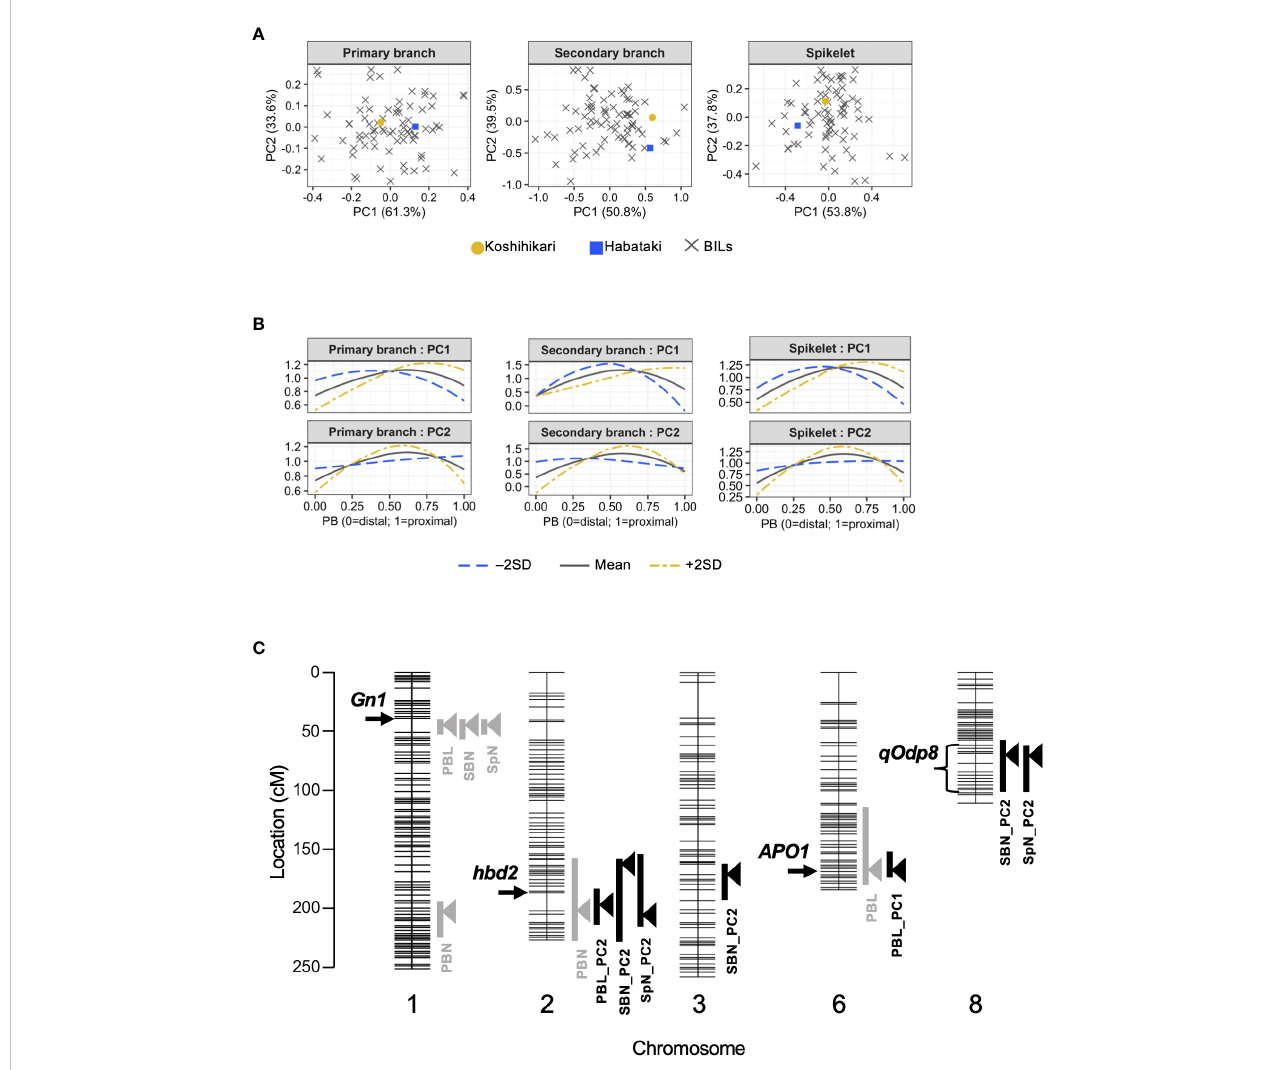
FIGURE 2 Quantitative trait locus (QTL) analysis of organ distribution patterns. (A) Organ distribution patterns in backcrossed inbred lines (BILs) derived from Koshihikari and Habataki. (B) Effect of each principal component (PC). Estimated organ distribution patterns were recalculated for mean ± 2 standard deviations (SD) of the PC. (C) Chromosomal location of the QTLs detected in this study. Horizontal lines indicate the positions of DNA markers. The arrowheads and bars on the right side of each chromosome indicate the position of the highest peak and – 2 logarithm of the odds (LOD) con fi dential interval, respectively. The arrows and bracket on the left side of each chromosome indicate the position of previously identi fi ed genes and a novel QTL, respectively. PBN, primary branch number; PBL, total primary branch length; SBN, total secondary branch number; SpN, total spikelet number; PBL_PCx, PCx of distribution pattern of primary branch length; SBN_PCx, PCx of distribution pattern of secondary branch number; SpN_PCx, PCx of distribution pattern of spikelet number.